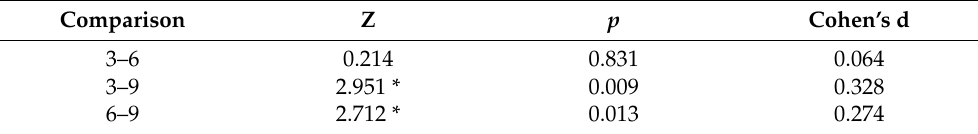
Table 8. The results of the post hoc test and effect size (Cohen’s d) for number of colors. Comparison